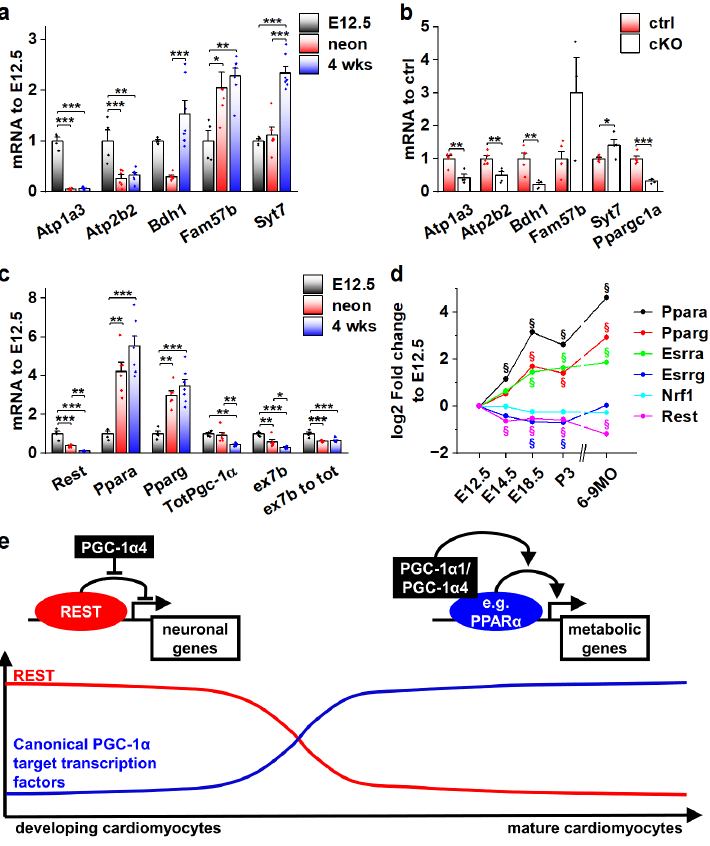
Figure 7. Actions of different PGC-1 α isoforms during normal cardiomyocyte development are con- trolled by the expression of their binding partners. ( a ) Gene expression of selected REST target genes in α 4 + control mouse ventricles at different ages ( n [E12.5] = 4, n [neonatal] = 6, n [four weeks] = 7). ( b ) Gene expression of selected REST target genes in PGC-1 α knockout mouse ventricles at E12.5 ( n [ctrl] = 4, n [ko] = 5). ( c ) Gene expression of PGC-1 α and its binding partners in α 4 + control mouse ventri- cles at different ages ( n [E12.5] = 4, n [neonatal] = 6, n [four weeks] = 7). ( d ) Gene expression of PGC- 1 α binding partners in α 4 + control mouse ventricles during embryonic and postnatal development.